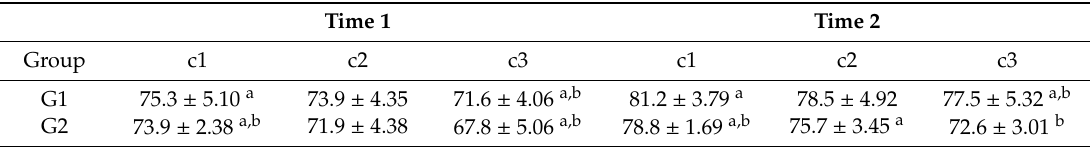
Table 1. The comparison of mean, standard deviation values and statistical di ff erences of the values of the two groups in each conditions and di ff erent times.